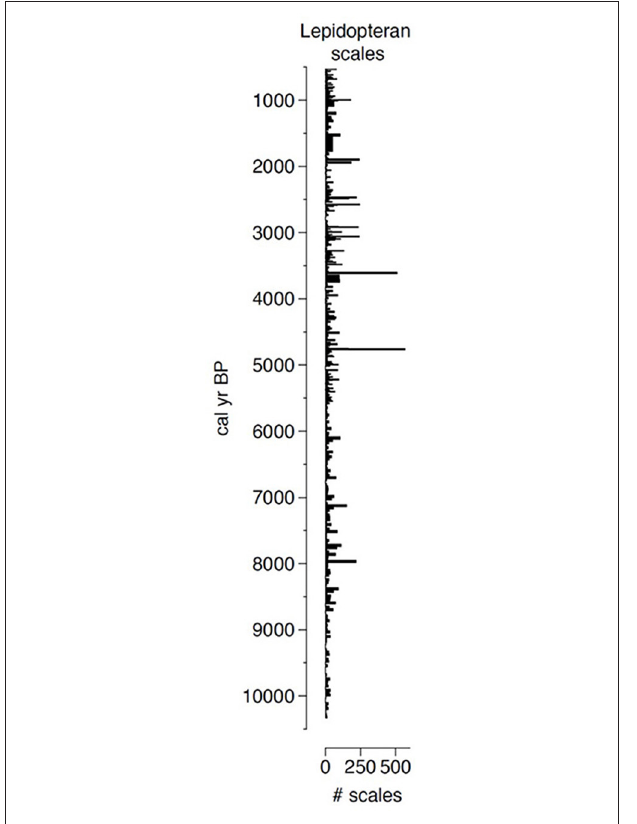
FIGURE 2 | Raw number of lepidopteran scales extracted for the last 10,000 years from a sediment core recovered from Lake Flévy, Quebec.